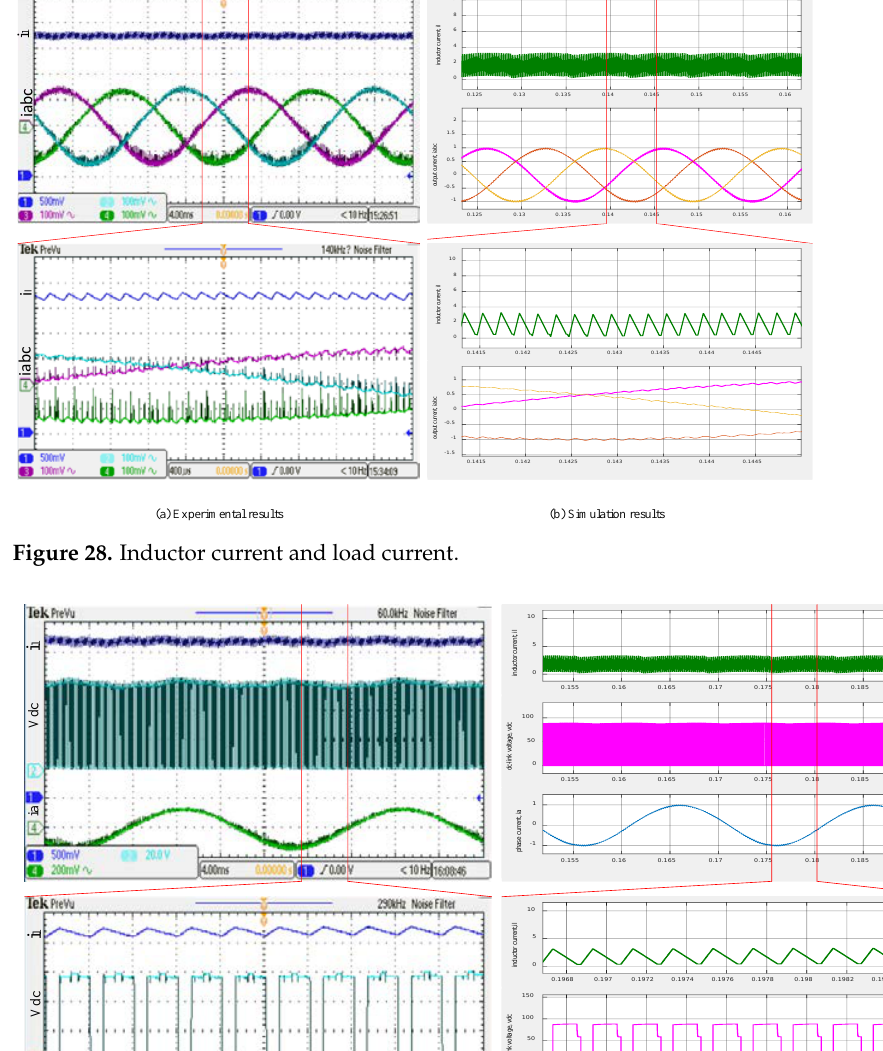
Figure 27. Gating pulses of upper and lower switch of the first inverter leg.